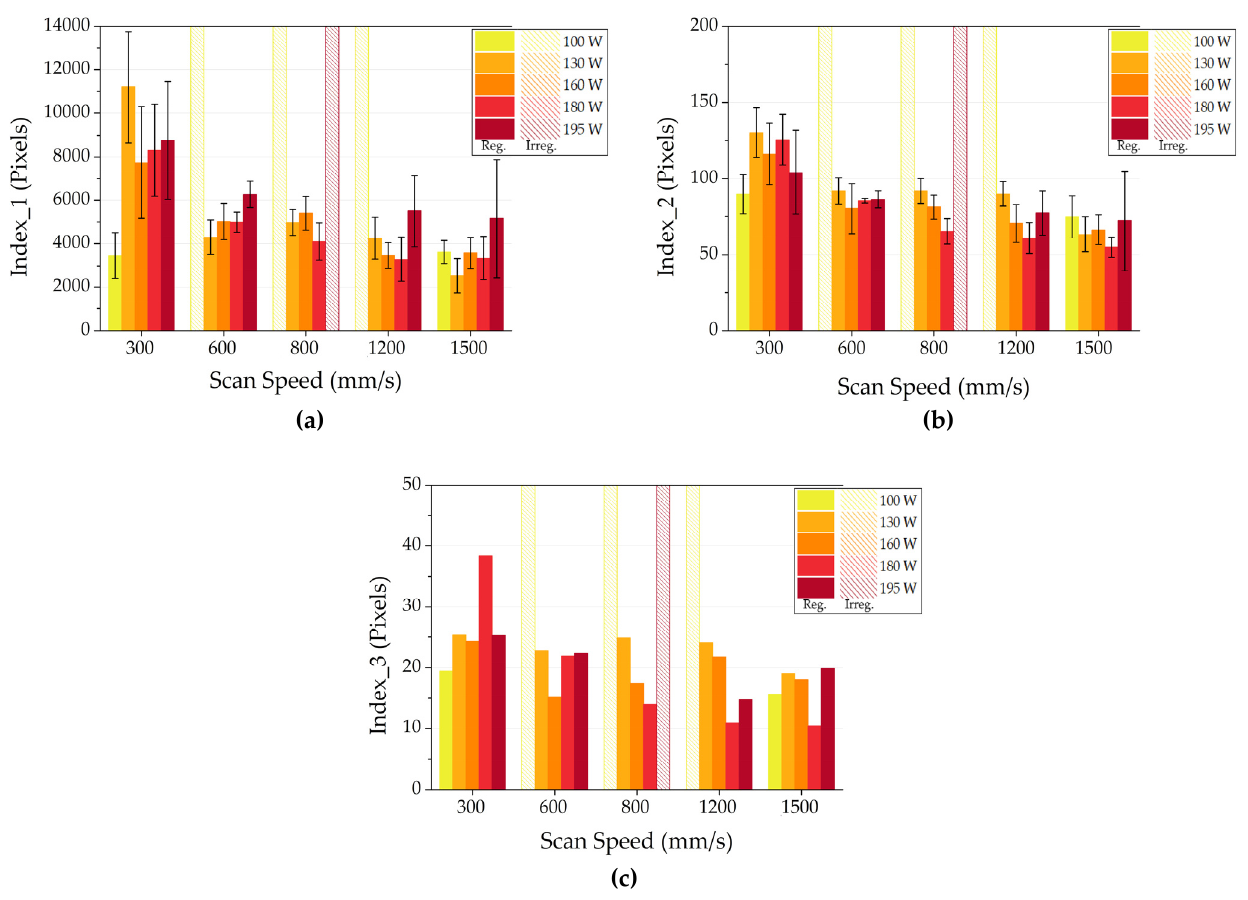
Figure 9. Index 1 ( a ), Index 2 ( b ) and Index 3 ( c ) for Al4Cu alloy.